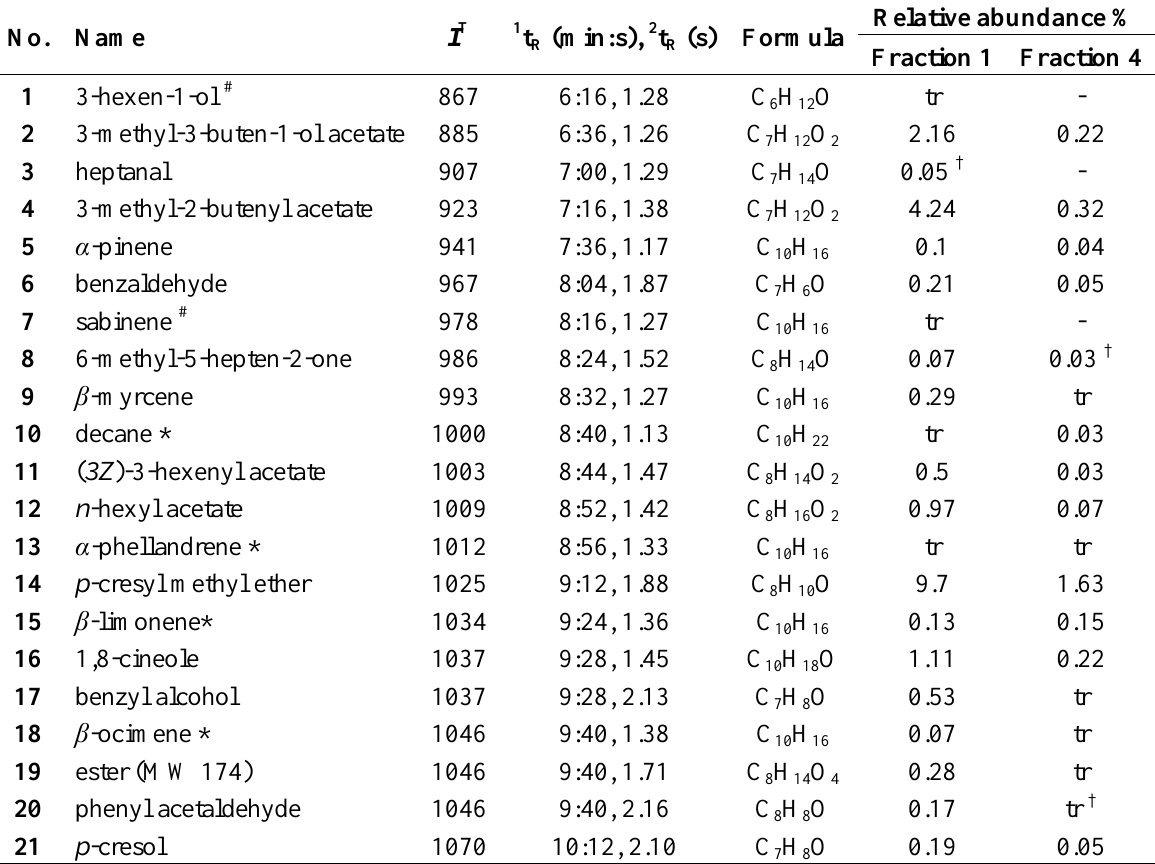
Table 1. Selected compounds from fractions 1 and 4 of ylang-ylang essential